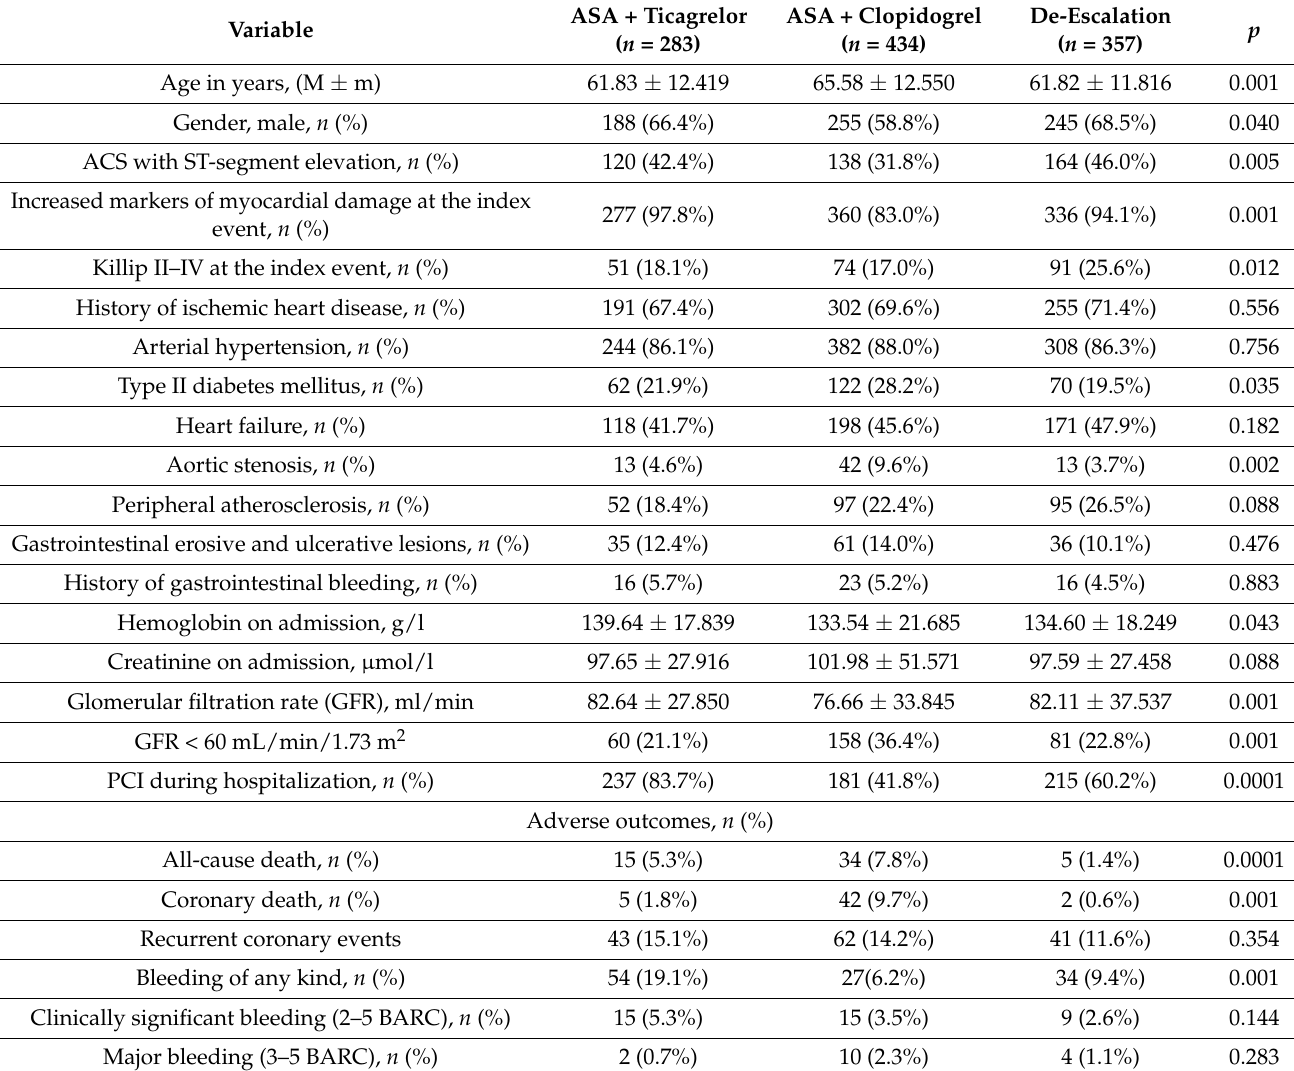
Table 3. Clinical characteristics of the patients on different regimens of APT.